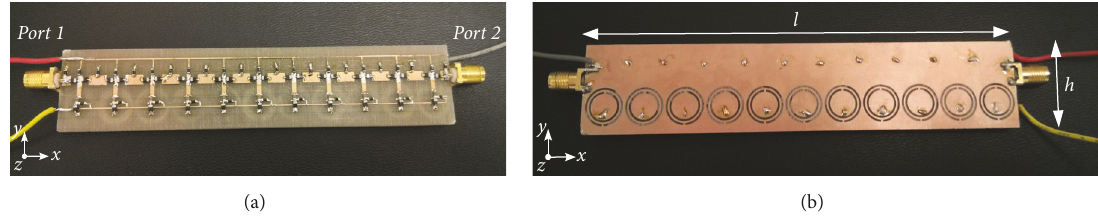
Figure 8: Picture of the miniaturized CRLH LWA. (a) Top layer with cascade or 𝑁 = 11 unit cells. (b) Bottom layer with CSRRs. The overall dimensions are 𝑙 = 11.5 cm, ℎ = 2.3 cm.